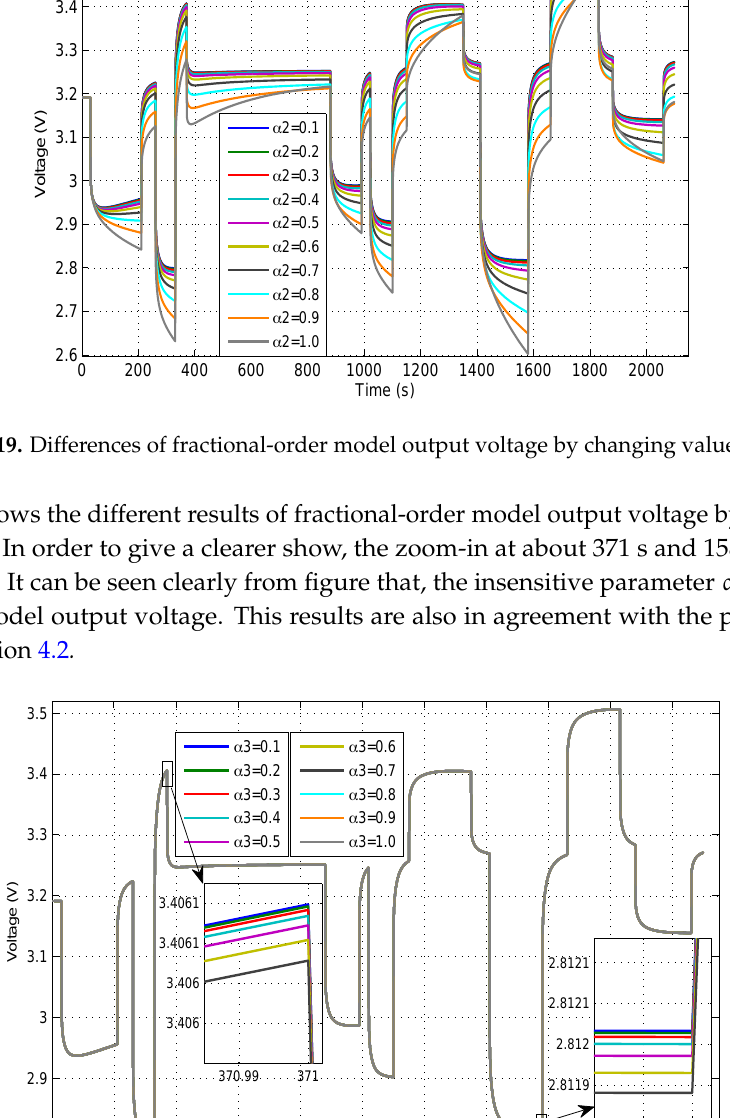
Figure 20. Differences of fractional ‐ order model output voltage by changing value of α (cid:2871) .